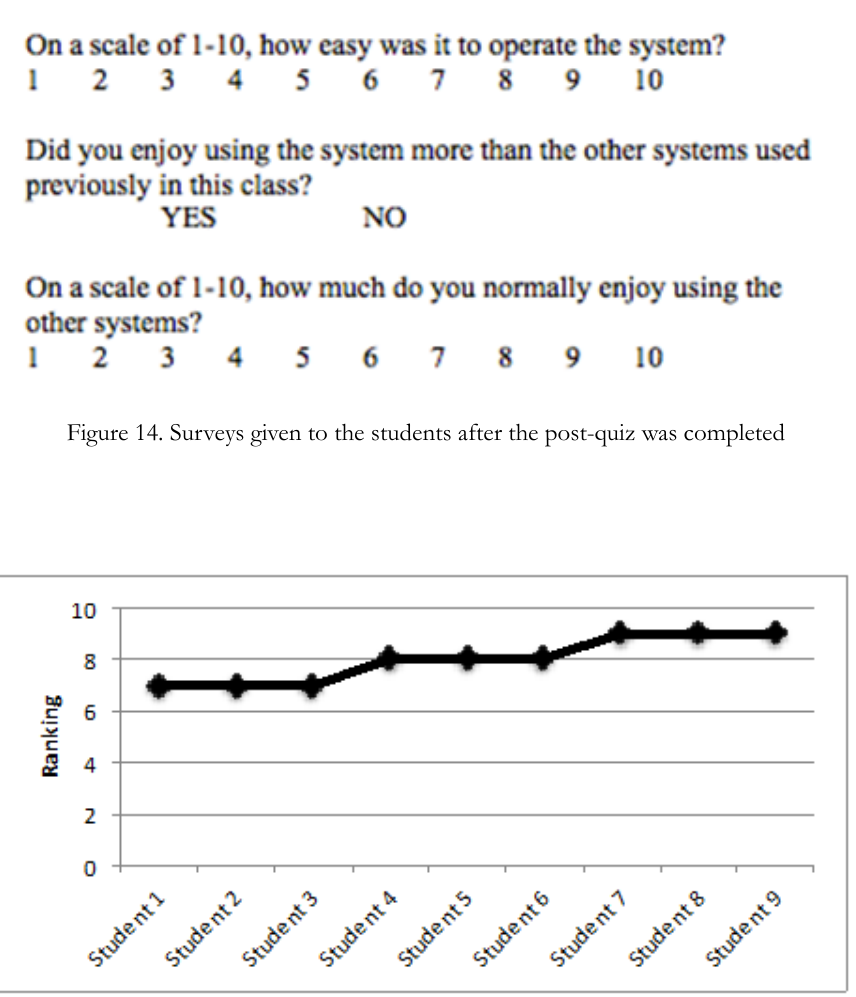
Figure 15. Ranking how much the students enjoyed using the system on a scale of